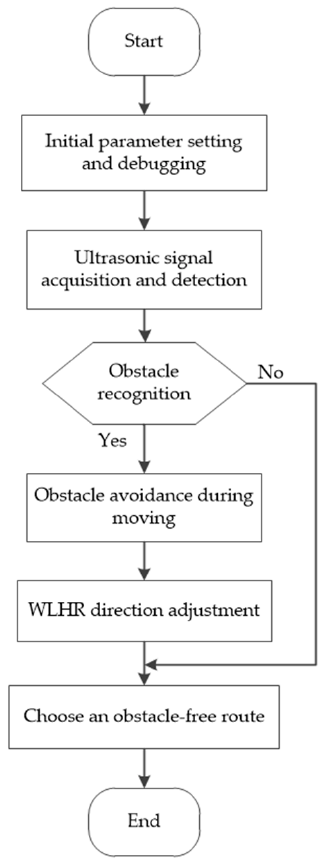
Figure 14. Operation flow chart of obstacle avoidance algorithm.